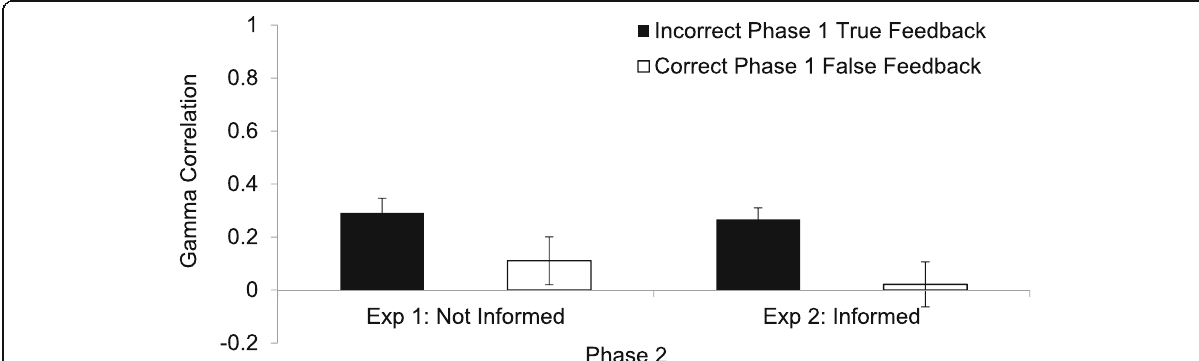
Fig. 1 The γ correlations between confidence in the factual accuracy of responses in the initial test and correct performance in Phase 2, in which recalling the red feedback word, regardless of whether it was true or false, was considered correct. The solid black bar represents the standard hypercorrection condition in which the participant answered incorrectly in Phase 1 and was given true feedback. The white bar provides the γ correlations when the participant responded correctly in Phase 1 and false feedback was given. On the left are the results from Experiment 1, in which participants were not informed about whether the to-be-learned word, provided as feedback in red, was true or false. On the right are the results from Experiment 2, in which participants were informed, immediately upon being presented with the to-be-learned word in red, whether the feedback was true or false. Error bars indicate the standard error of the mean